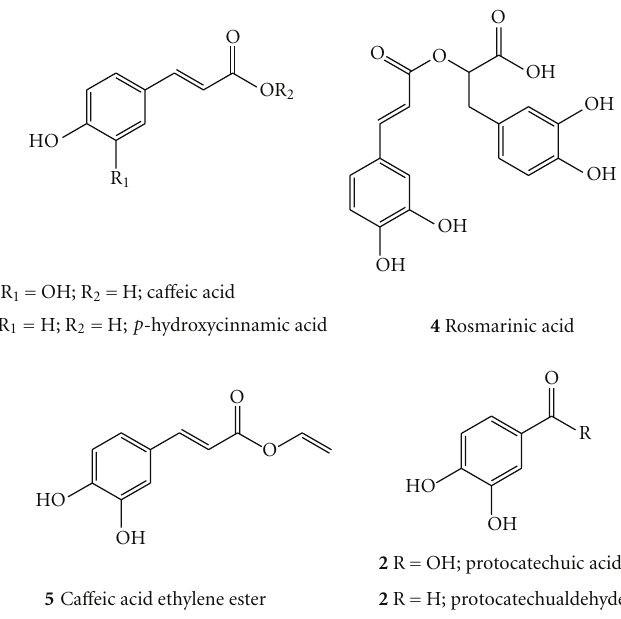
Figure 1: Structures of compounds isolated from P. vulgaris L.